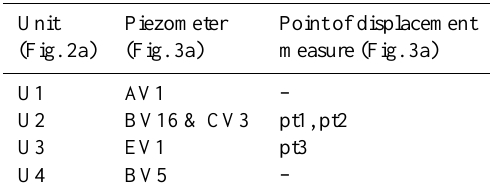
Table 2. Landslide unit and corresponding measuring points (see also Figs. 2a and